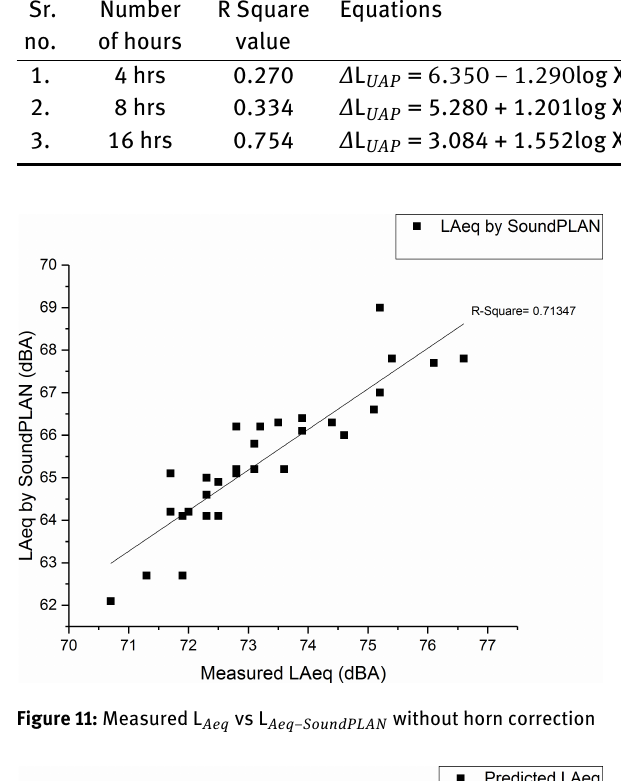
As explained above, a new correction factor exclu- sively for daytime ∆ L UAP was derived using 4 hours, 8 hours, and 16 hours data. Accuracy of each model derived for 4 hours, 8 hours, and 16 hours are tabulated in table no.